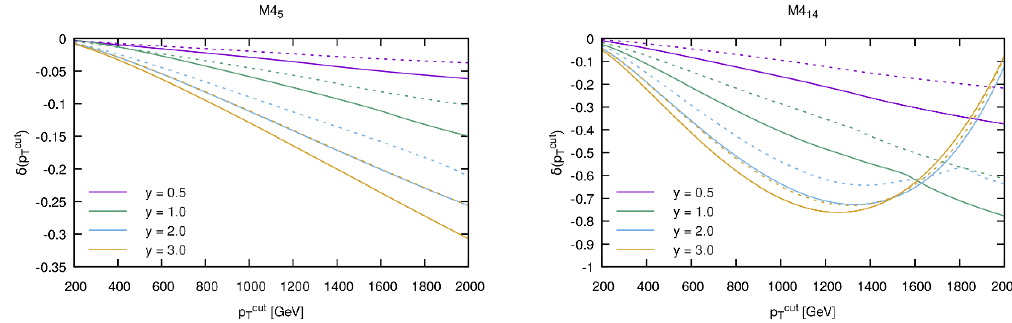
) for benchmark scenario 2 and the four models considered in T